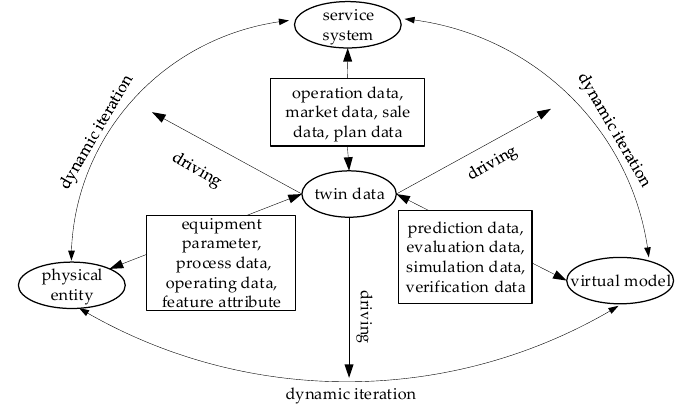
Figure 2. A five-dimension digital twin model.